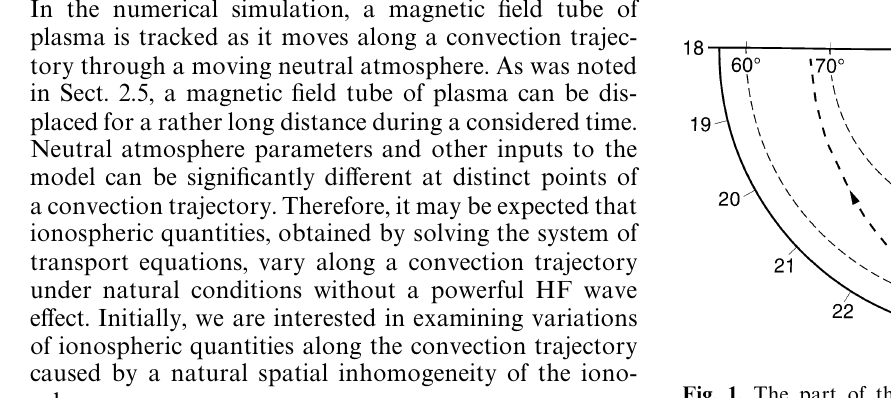
Fig. 1. The part of the convection trajectory around which the magnetic field tube of plasma is carried in the numerical simulation. Arrows on the trajectory indicate the direction of the convection flow. Locations of the plasma tube are labelled for 0, 20, and 1500 s after turn on of a power HF wave